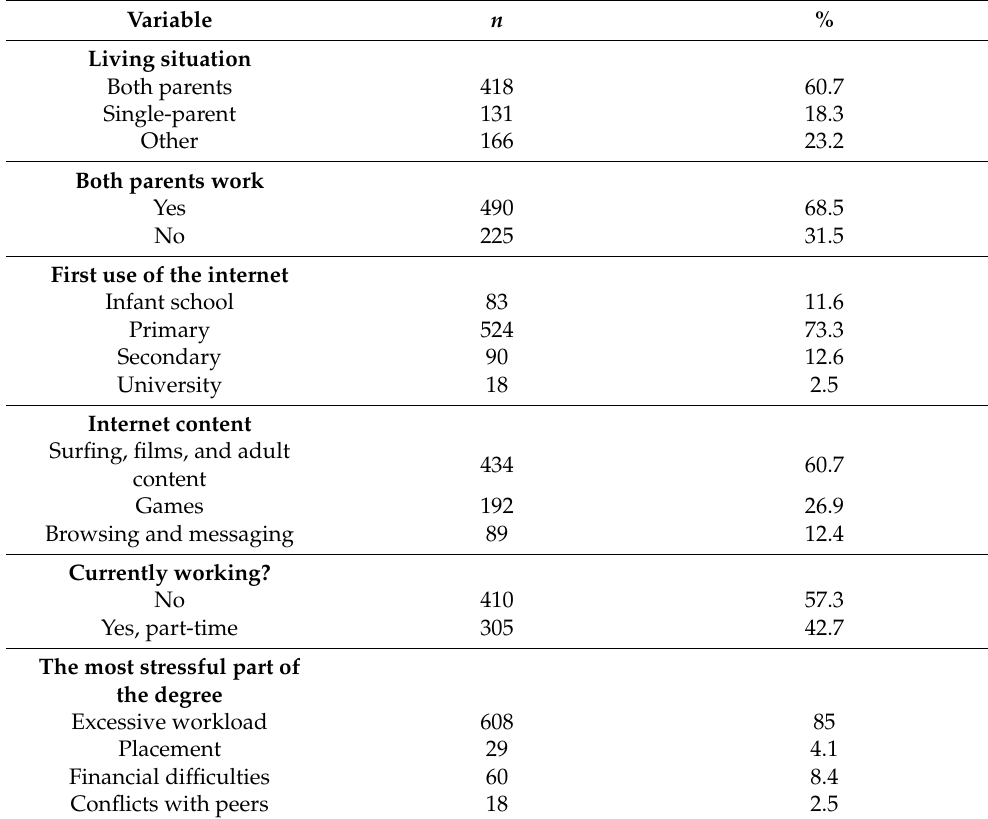
Table 2. Sociodemographic data and internet use ( n = 715).